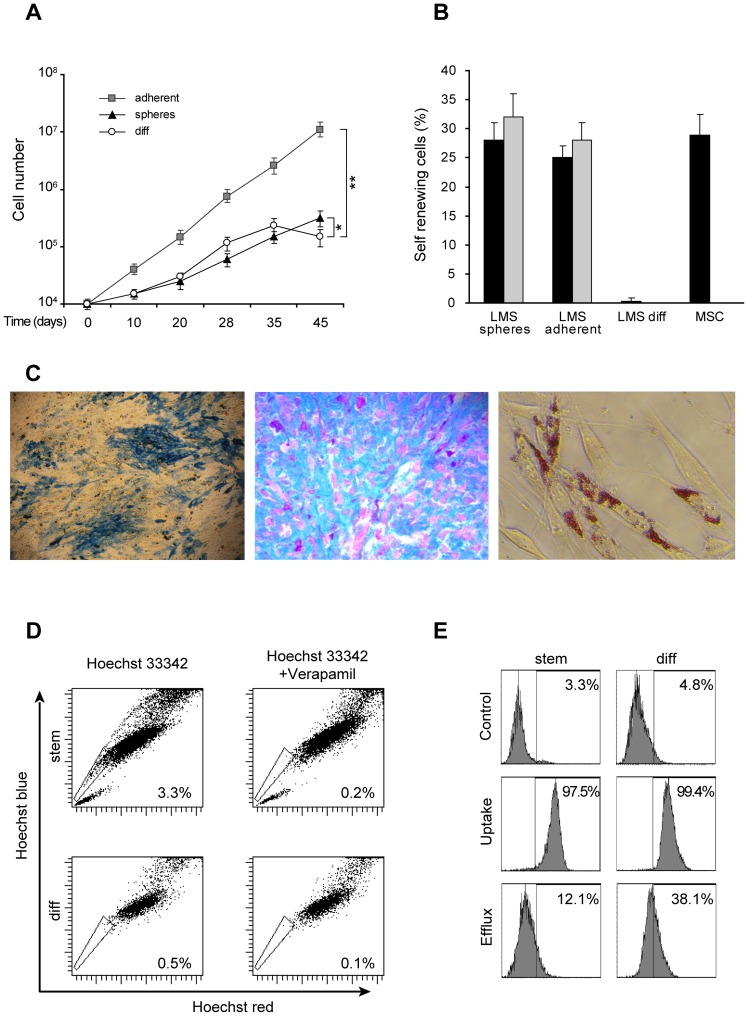
Undifferentiated LMS cells display stem cell potential in vitro.A) Growth curve of undifferentiated LMS cells isolated as spheres or adherent cultures as indicated, and of differentiated tumor cells (diff) obtained under standard conditions. The values represent mean +/− SD of three independent experiments. Student’ s T test was used to determine p-value. * p<0,05; **p<0,01. B) Self renewing ability (percentage of clonogenic cells) of undifferentiated (LMS spheres and LMS adherent) differentiated (LMS diff) LMS cells and MSC. Black bars represent primary assay, grey bars are secondary assays. Mean ± SD of 3 independent experiments is shown. C) Mesenchymal differentiation of LMS stem like-cells: (left) Osteogenic differentiation (Alcaline Phosphatase activity), (middle) Chondrogenic differentiation (Alcian-PAS), (right) Adipogenic differentiation (Oil-red-O). D) Flow cytometry analysis of Hoechst 33342-stained cells. The percentage of side population (SP) cells (gated) is indicated. E) Cytoﬂuorimetric profile of LMS undifferentiated (stem) and differentiated (diff) cells, untreated (Control), after O/N exposure to 5 µM doxorubicin (Uptake), or after 2 h of drug treatment followed by washing and overnight incubation in fresh medium (Efﬂux).